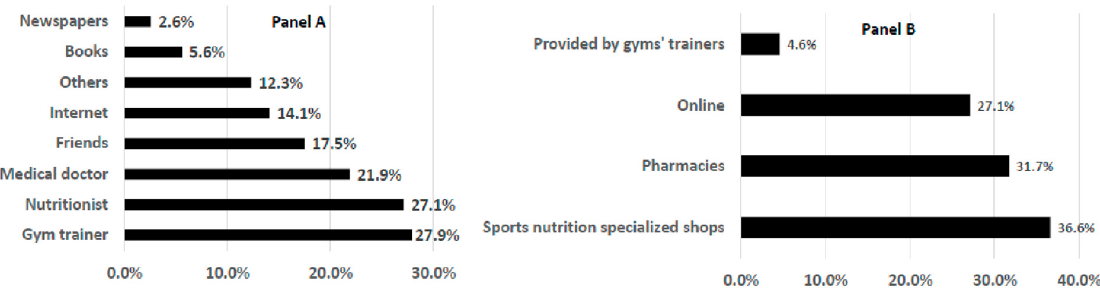
Figure 3. Supplement supply in the sub-sample that reported obtaining them ( n = 268): Panel A—who suggested the use of supplements? Panel B—where were the supplements bought? Gym trainers were the preferred source of information for supplement prescription; with statistically significant differences ( p < 0.001) found between sexes; males reported consulting gym trainers more frequently (84%) than females. No other significant differences were observed. Reading the labels of sport food supplements was reported by a large proportion of respondents (85.1%) (data not shown). 3.4. Multivariate Statistical Correlation Analysis The use of supplements for sport was found to be correlated with only three characteristics among the physical and lifestyle factors (Table 1) and those related to the typology and timing of sports and diet attitude (Table 2). Multivariate correlation analysis was performed using a logistic regression model that expressed the natural logarithm of the odds of an event (e.g., the respondent uses supplements for sport) as a linear combination of the characteristics of the sample. A total of 87.1% of respondents who performed strength training, and followed a diet prescribed by a gym’s trainer specifically designed for sport, used supplements. The food supplements most frequently used by this sub-group were proteins and protein bars (77.8%), branched-chain amino acids (63.0%), amino acid pills (59.3%), and caffeine (47.6%). In addition, supplement use was reported by 63.3% of respondents following a regimen for sport. The data showed that 84.4% of those following a diet prescribed by a gym trainer, and 52.8% of those performing strength training, were using supplements. The same analysis was performed on the characteristics of the respondents following a specific diet for sport. In this case, only five characteristics were found to be related to the pursuit of a diet. A total of 56.3% of respondents with BMI > 30 kg/m 2 , and 50.0% of those whose highest level of education was secondary school, followed a diet. In addition, most of the attendees who consumed alcoholic beverages (73.3%) did not follow a sport-specific diet. The same was true for 63.3% of attendees training for strength, and 66.3% of those training for fitness. 3.5. Nutritional Knowledge Related to Sport The mean NKS score assessed in the present sample was 18.8 ± 5.4 with a correct response rate of 57.1% (Table 5). The proportion of respondents that had a sufficient level of NKS (meaning ≥ 60% of correct answers) was 47.3%. The theoretical maximum (33 points) was not achieved by any of the respondents, although there were differences among sections. NKS4, the energy balance section, achieved the highest rates (65.6% of correct answers and 64.2% of sufficient level of NKS), while the lowest percentages were